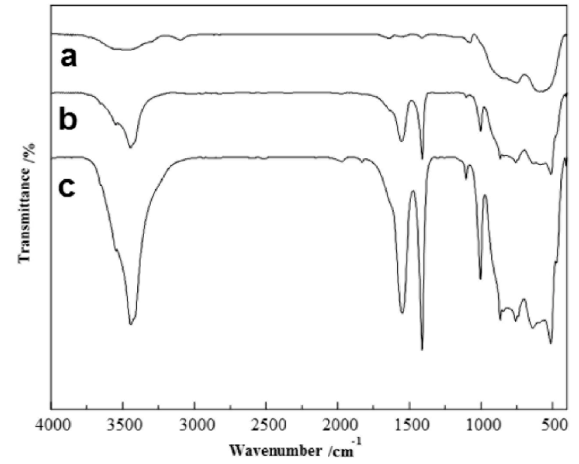
Figure 5. FT-IR spectra of ( a ) γ -Al 2 O 3 ; ( b ) Fe/ γ -Al 2 O 3; (c). Fe-Co/ γ -Al 2 O 3 .